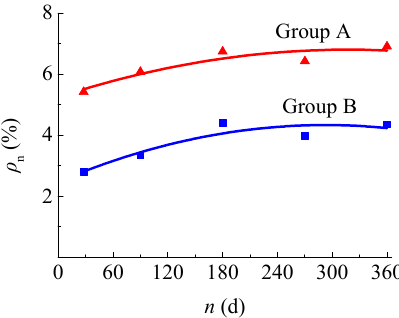
Figure 7. Variation of concrete moisture contents with soaking time.